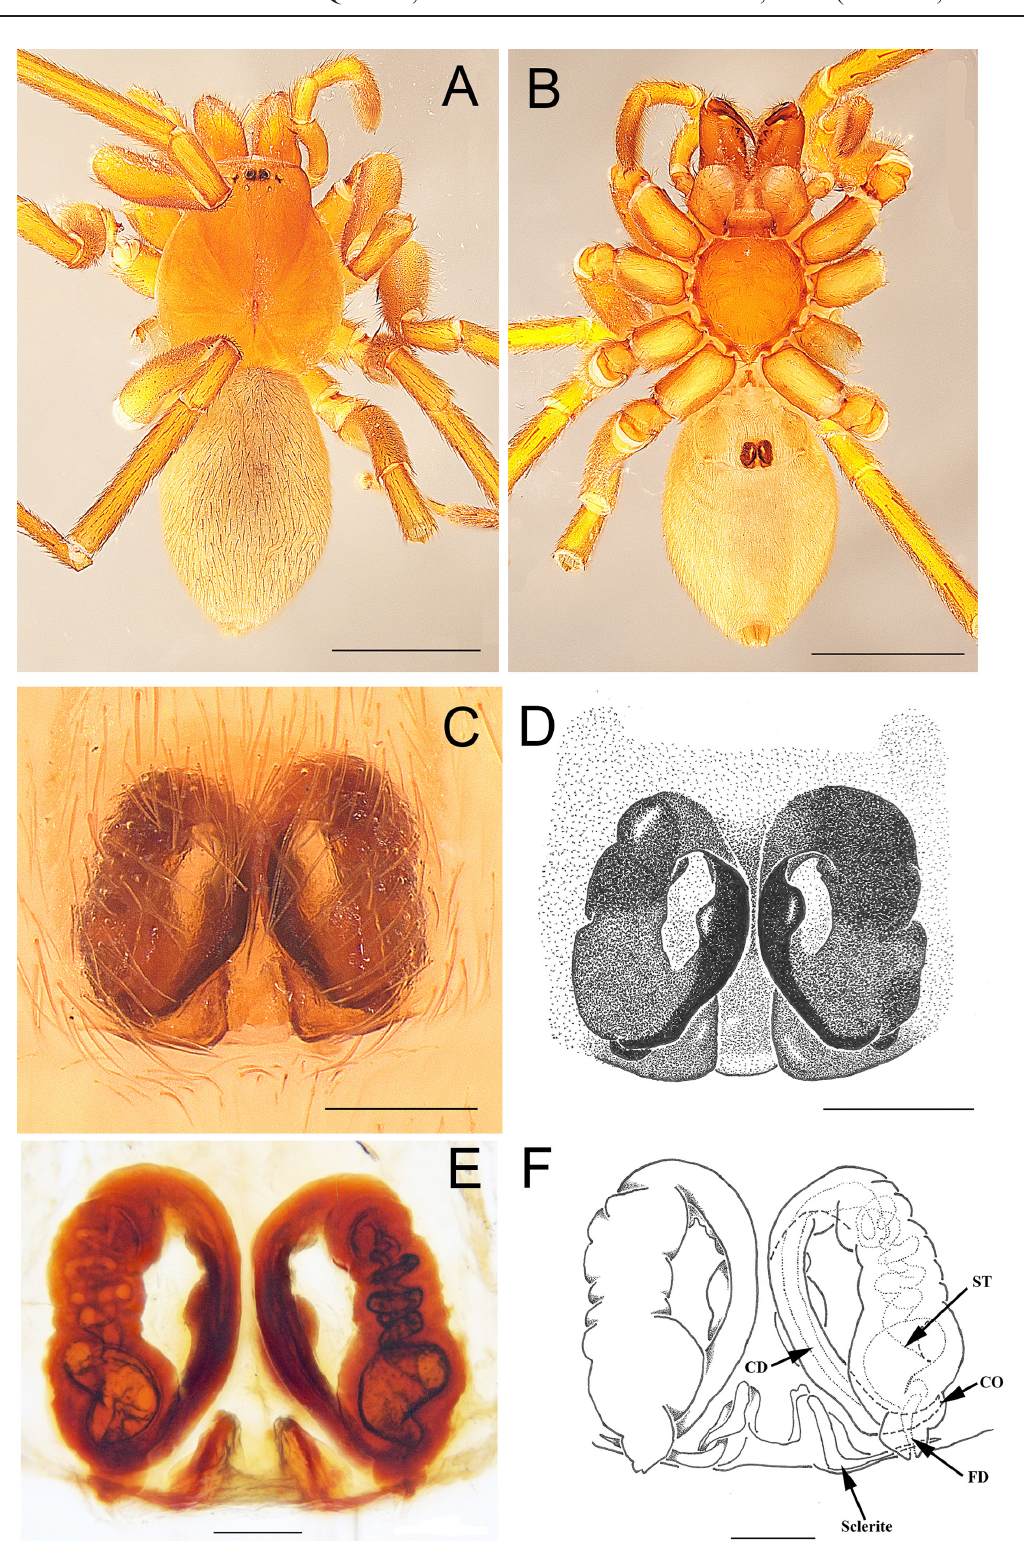
Fig. 37. Andromma velum sp. nov., ♀, paratype (BE_RMCA_ARA.Ara 153005). A . Habitus, dorsal view. B . Same, ventral view. C–D . Epigyne, ventral view. E–F . Same cleared, dorsal view. Abbreviations: CD = copulatory duct; CO = copulatory opening; FD = fertilisation duct; ST = spermatheca. Scale bars: A–B = 1 mm; C–D = 0.2 mm; E–F =